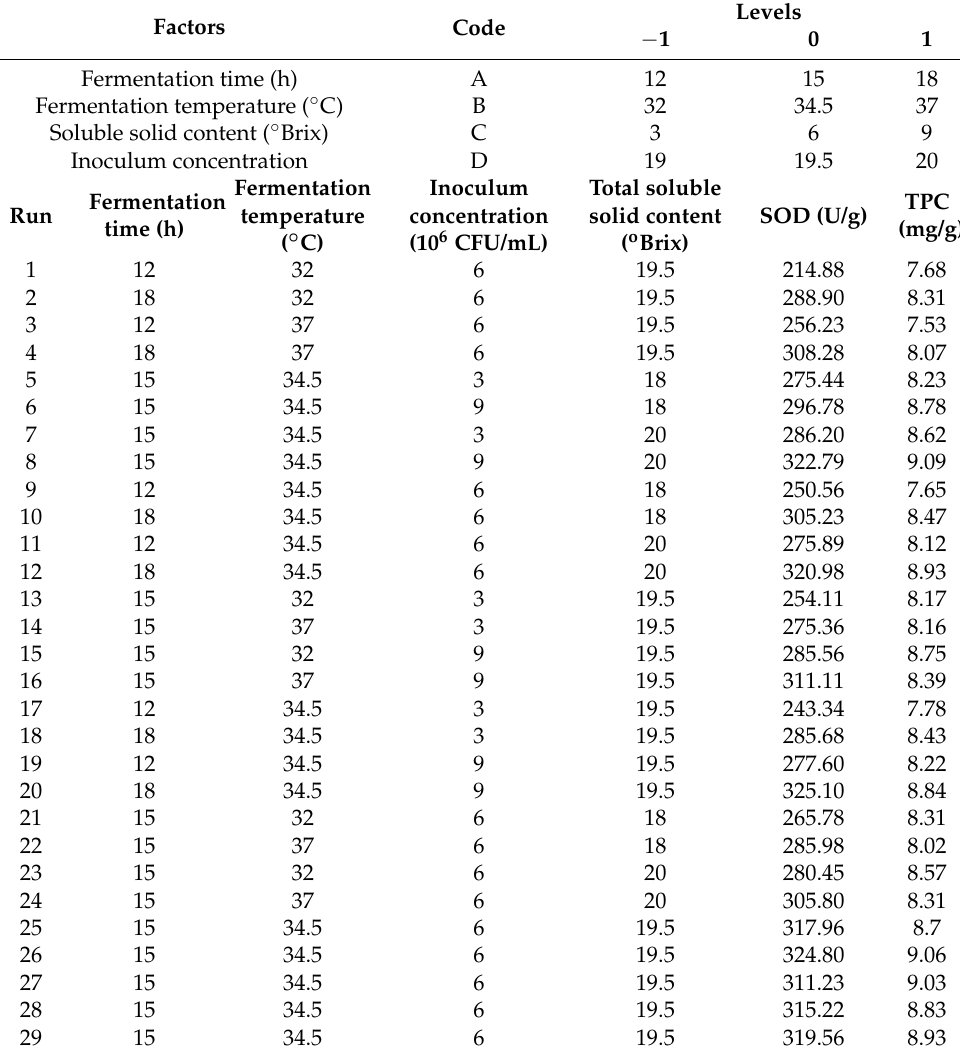
Table 2. Uncoded and coded levels of independent variables and combined model design expert test matrix and experimental data for responses in